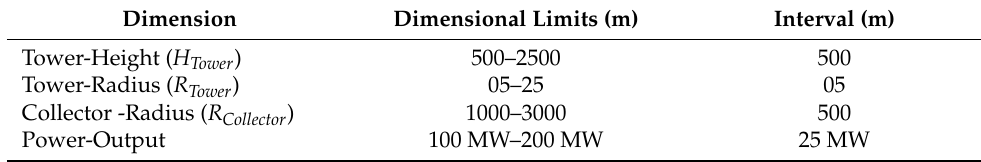
Table 3. Selected dimensions, limits, and intervals for model simulation.